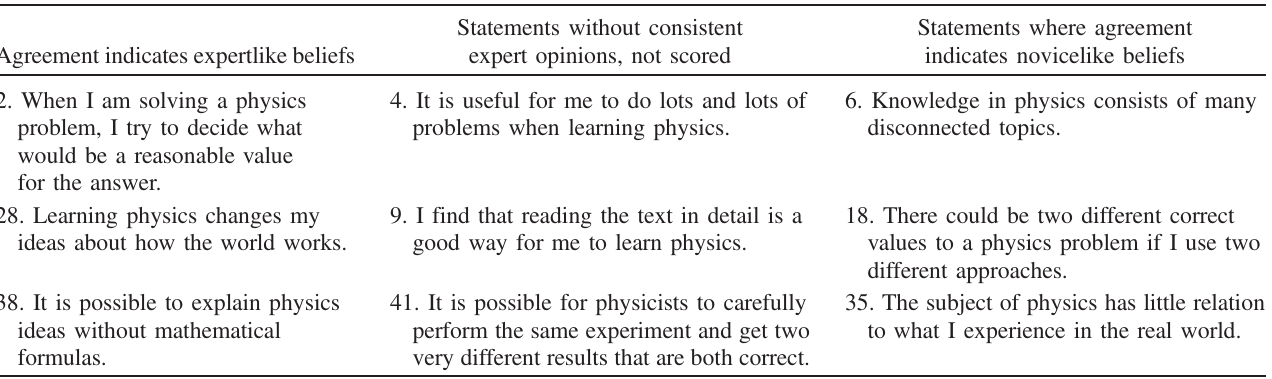
TABLE I. Examples of CLASS statements by category. Agreement indicates expertlike